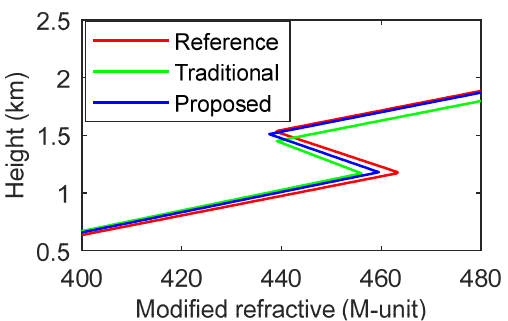
Figure 14. Atmospheric duct inversion is compared under different loss functions (red is the reference value, green is the traditional loss function inversion result, and blue is the proposed loss function inversion result).